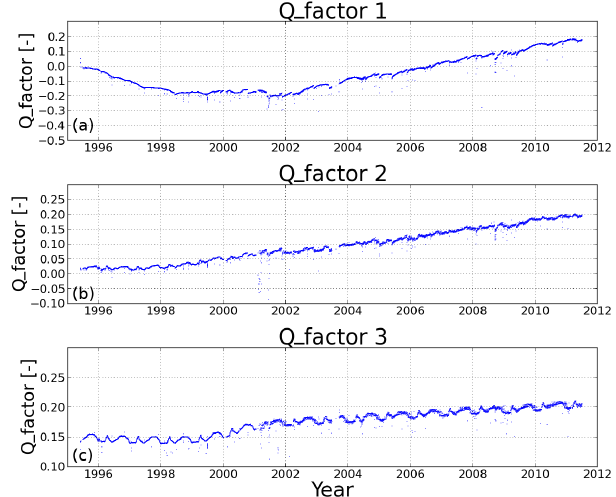
Figure 6. Relative change of PMD signals as a function of time from 1995 to 2011 for PMDs 1, 2, and 3 (a–c) . Reference measure- ment is from 3 July 1995.